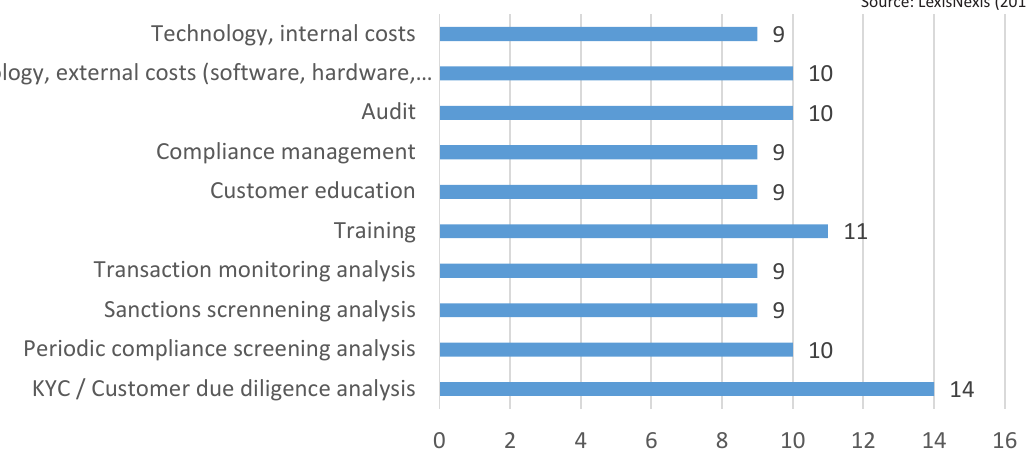
Figure 5. Breakdown of compliance costs by functions (banks in Asia region,